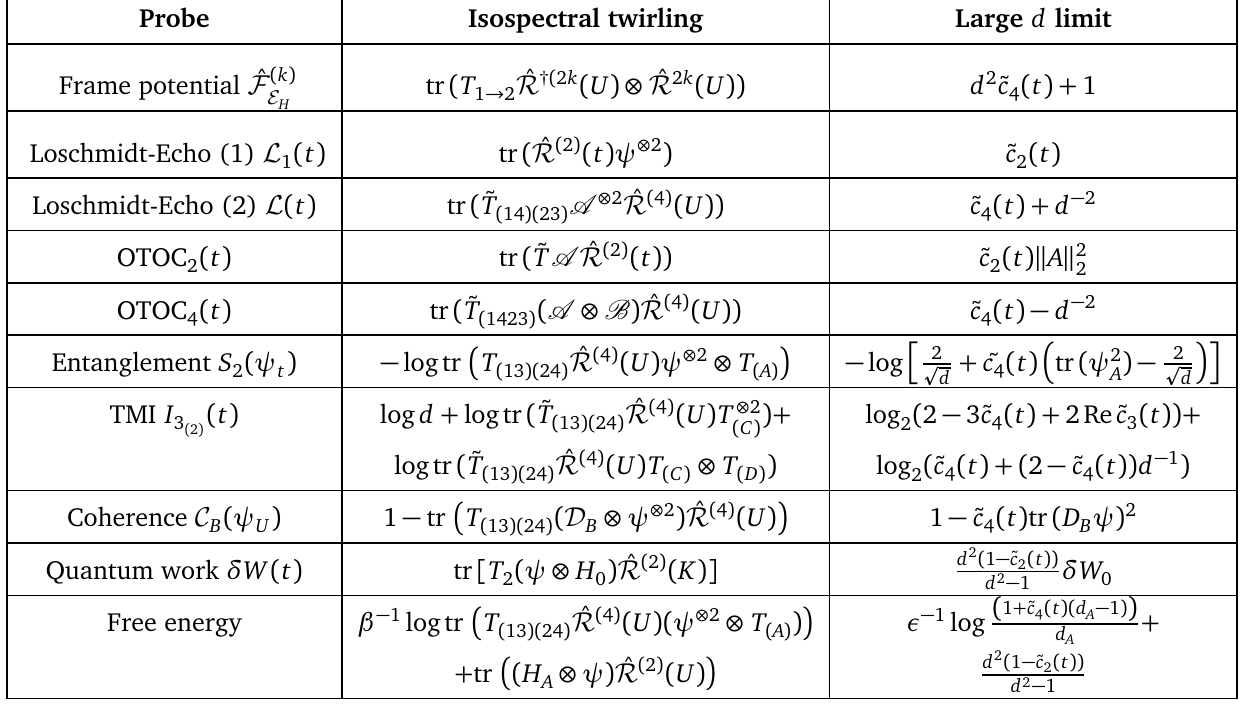
Table 1: Table of the Isospectral twirling for the different probes to chaos presented, and its large d limit. Here A ∈ B ( H ⊗ 2 ) , A = A † ⊗ A is a bounded operator on H ⊗ 2 and all the T π operators are some permutations; for a precise definition see the corresponding